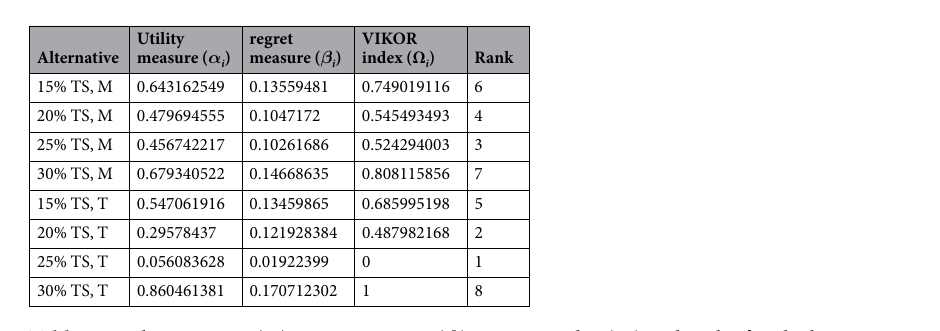
Table 9. Utility measure ( α i ), regret measure ( β i ), VIKOR index (Ω i ) and rank of each